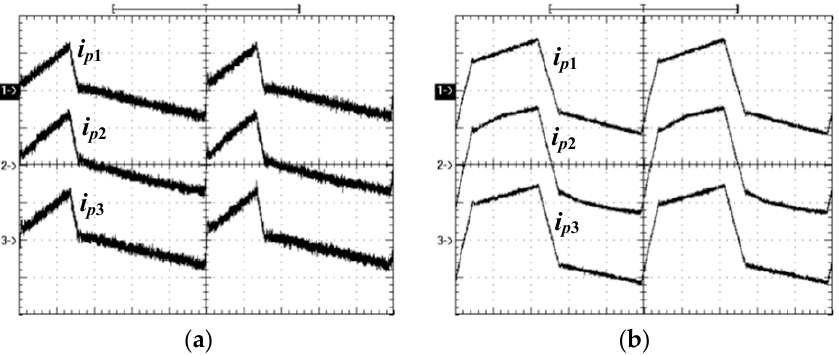
Figure 9. Test results of the primary side currents under ( a ) 20% load [ i p 1 ~ i p 3 : 2 A/div; time: 2 µs]; ( b ) full load [ i p 1 ~ i p 3 : 5 A/div; time: 2 µs].